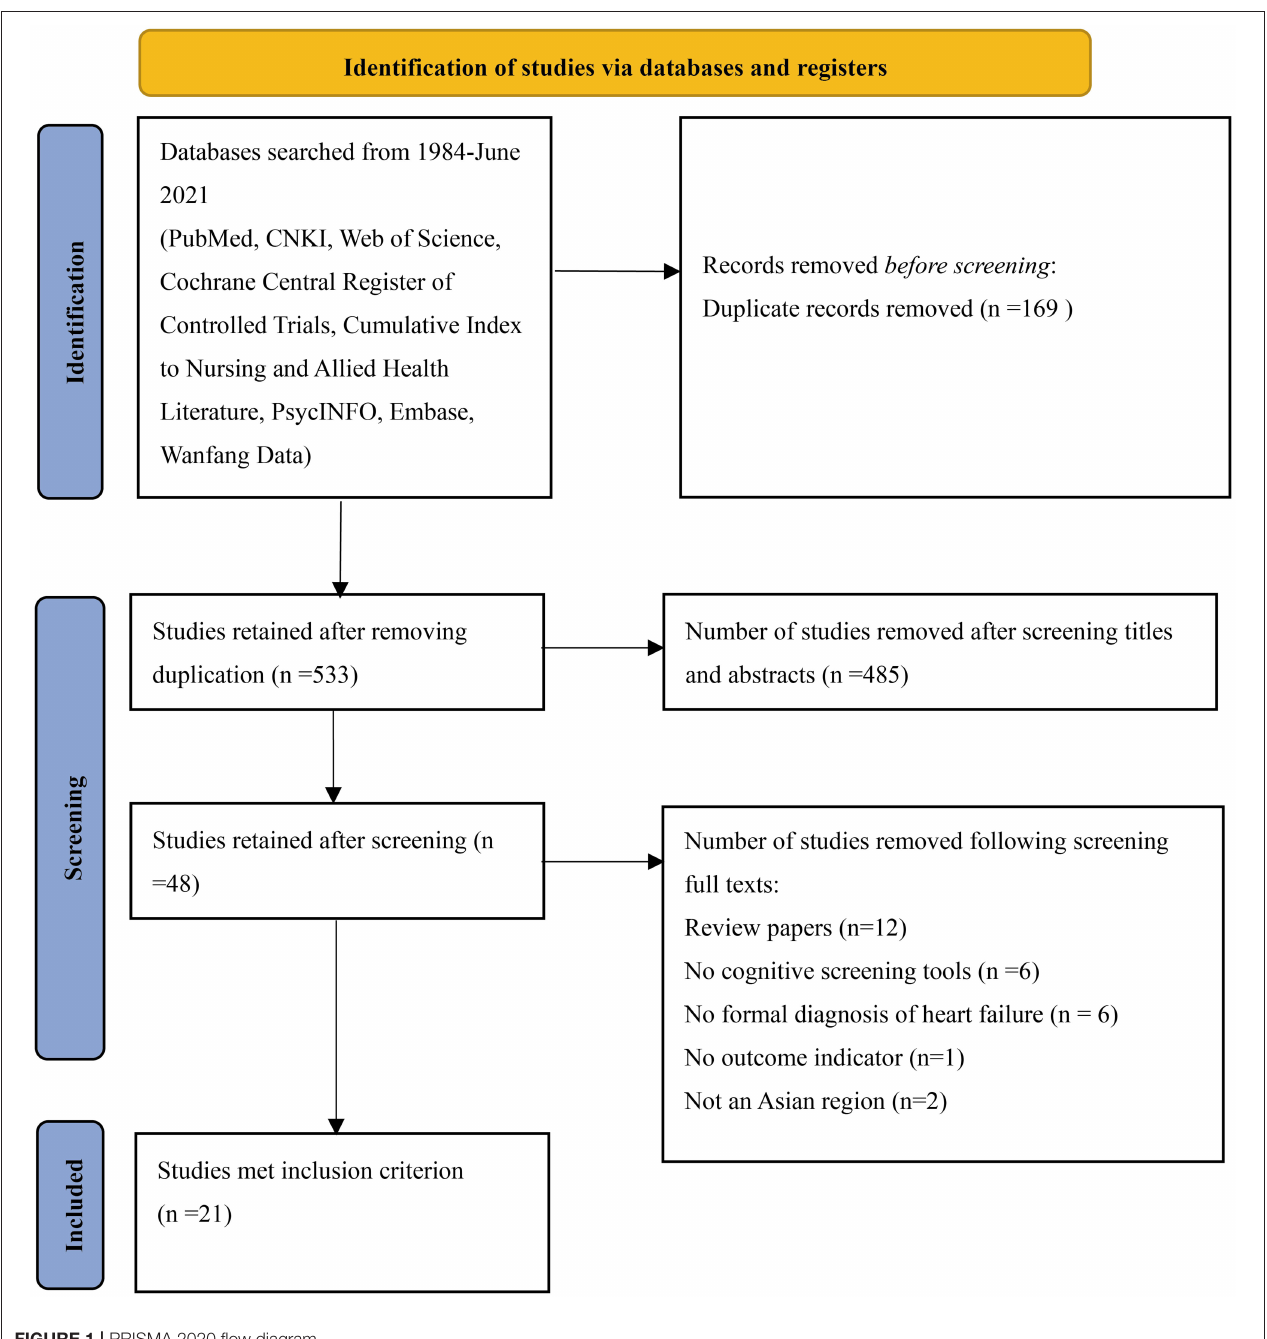
FIGURE 1 | PRISMA 2020 flow